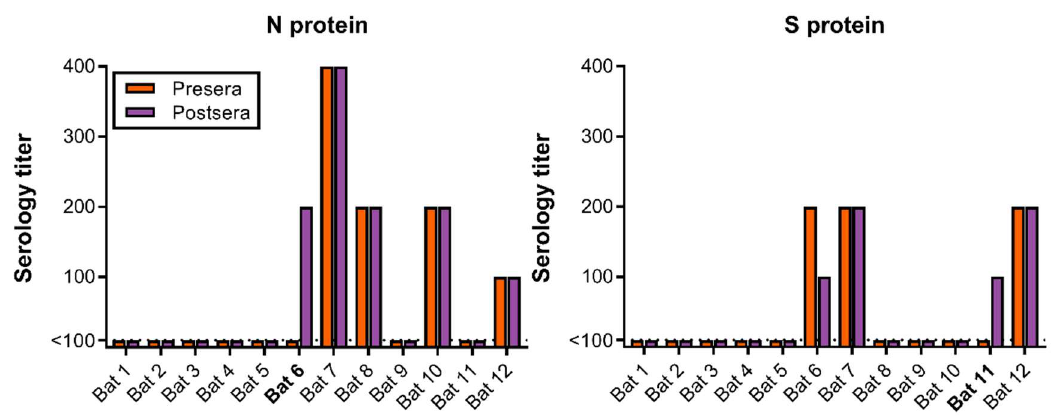
Figure 5. Serology titers in sera obtained pre- and post-challenge. ELISA assays were performed using SARS-CoV proteins N and S. Bats with an increase in serology titer are shown in bold. 228